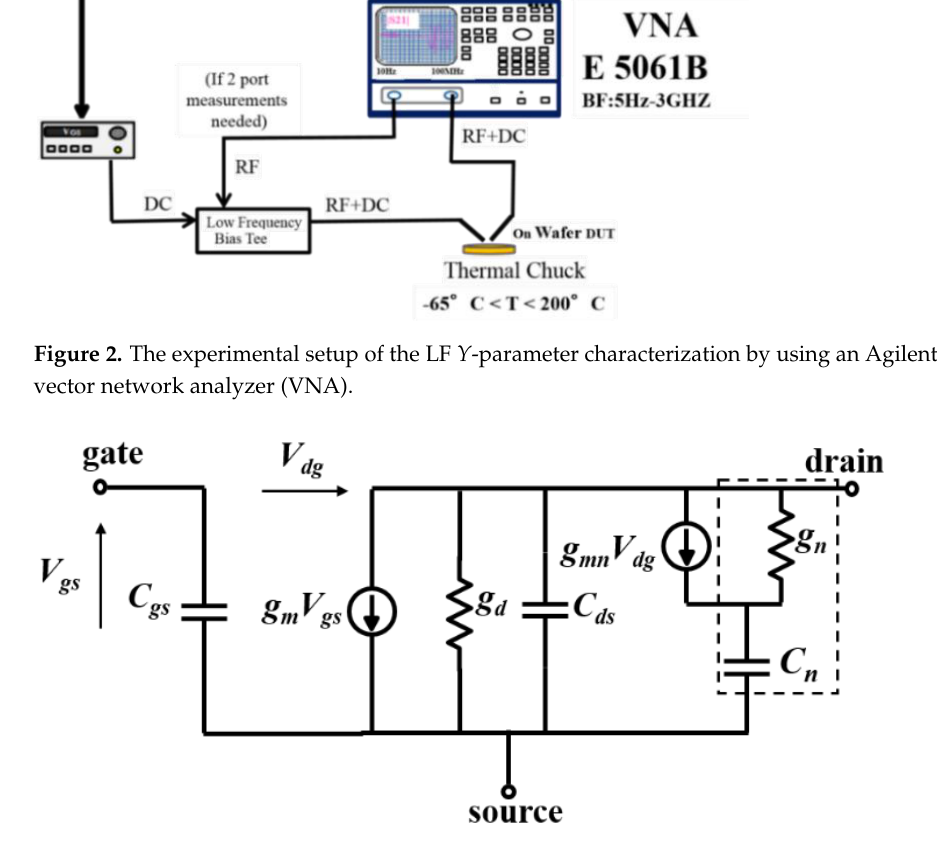
Figure 3. HEMT equivalent small signal circuit model accounting single trap signatures ( g n , C n ).